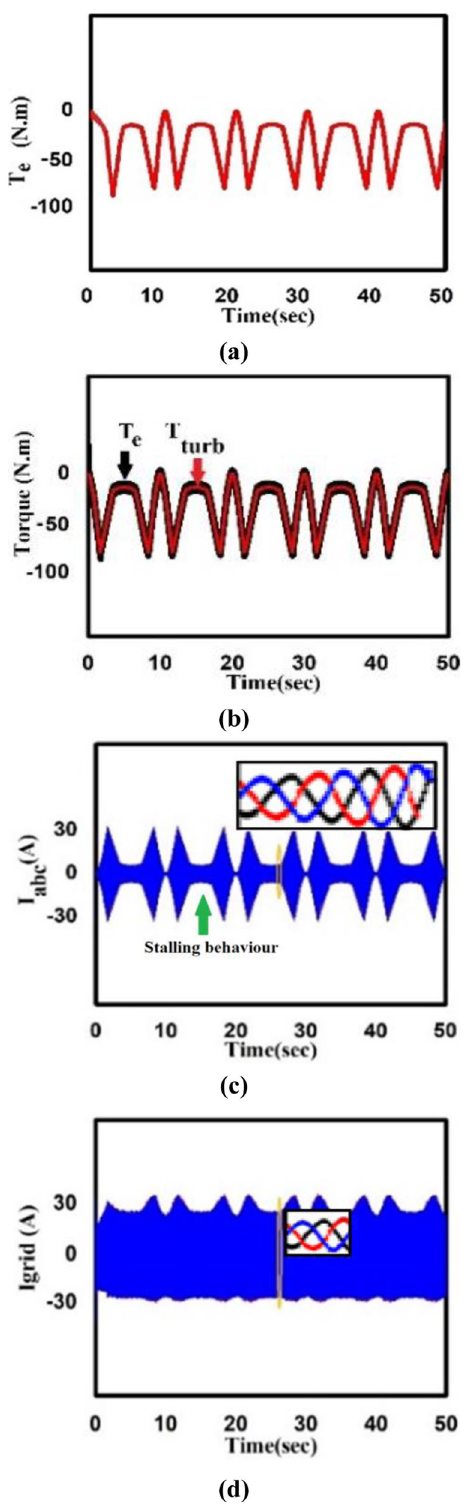
Fig. 11 Torques and adaptive control-based outputs. a) T e based on FOC strategy. b) T e based on the adaptive control strategy. c) Machine side current output. d) Grid side current output